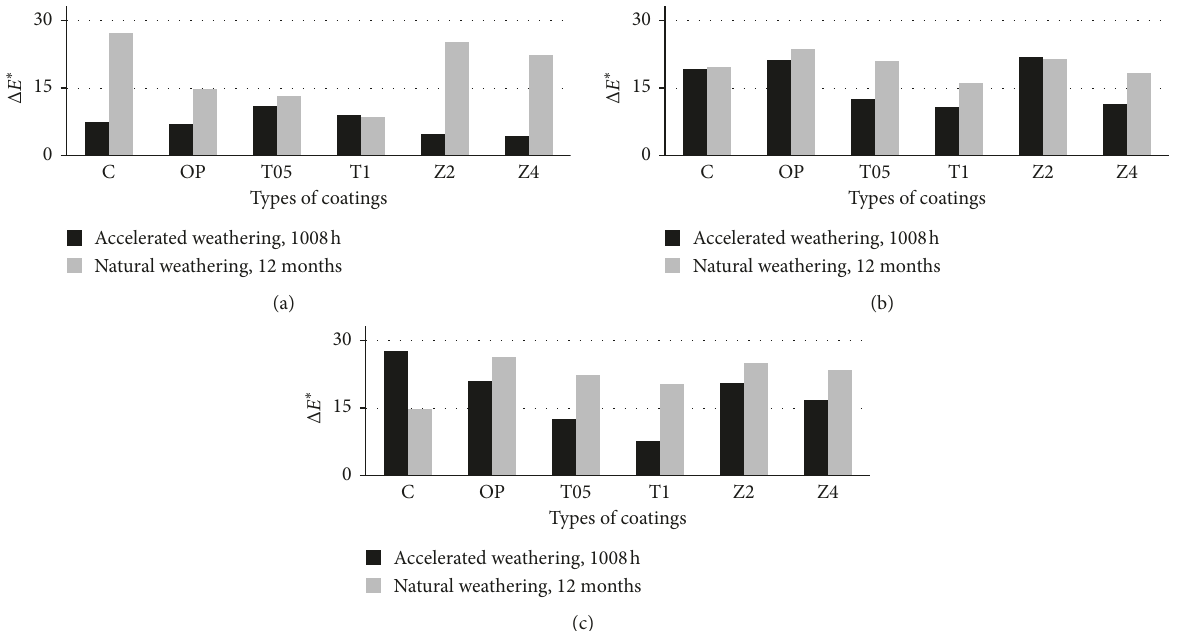
Figure 3: Colour change of untreated (N) (a) and heat-treated beech wood at 190 (b) and 212 ° C (c). The samples were uncoated (C), coated with net coating (OP), TiO 2 nanocoatings concentration 0.5 and 1% (T05 and T1), and ZnO nanocoatings concentration 2 and 4% (Z2 and Z4)